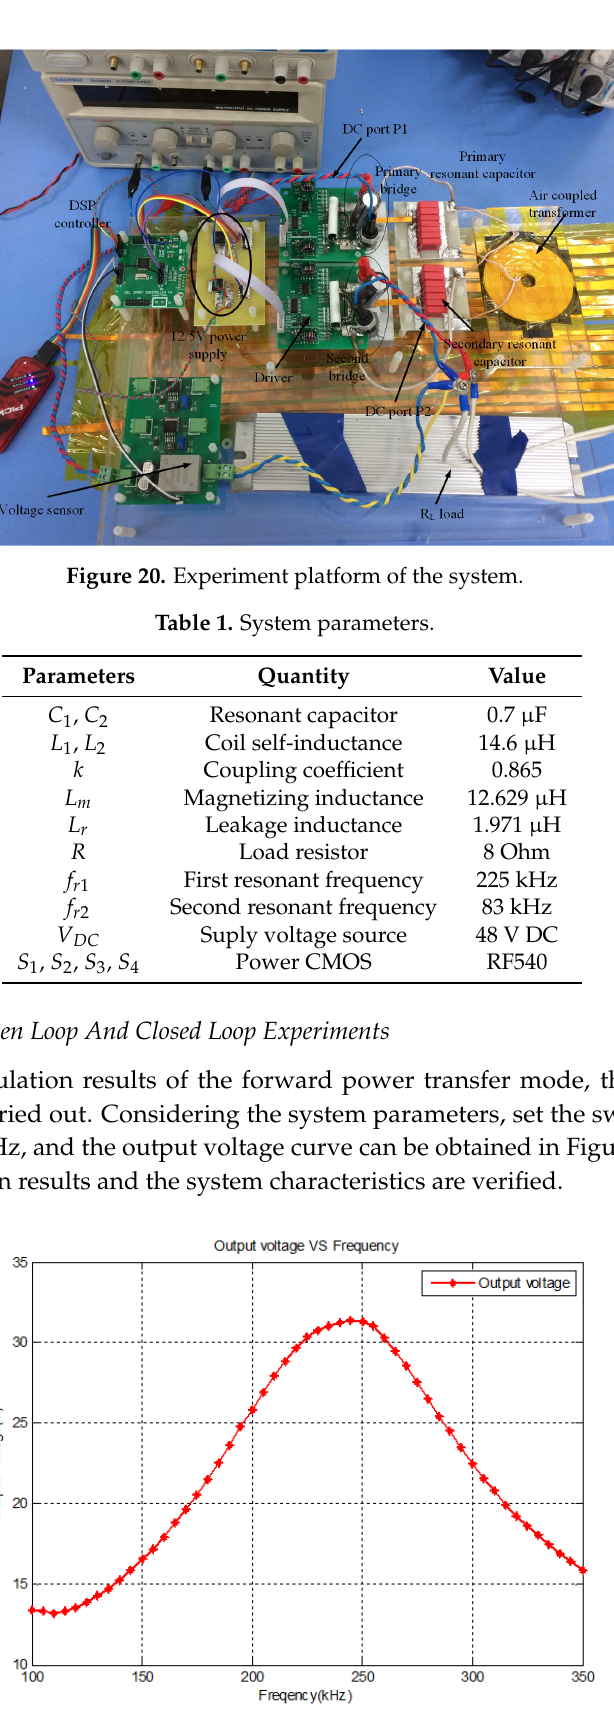
Figure 21. Output voltage vs.